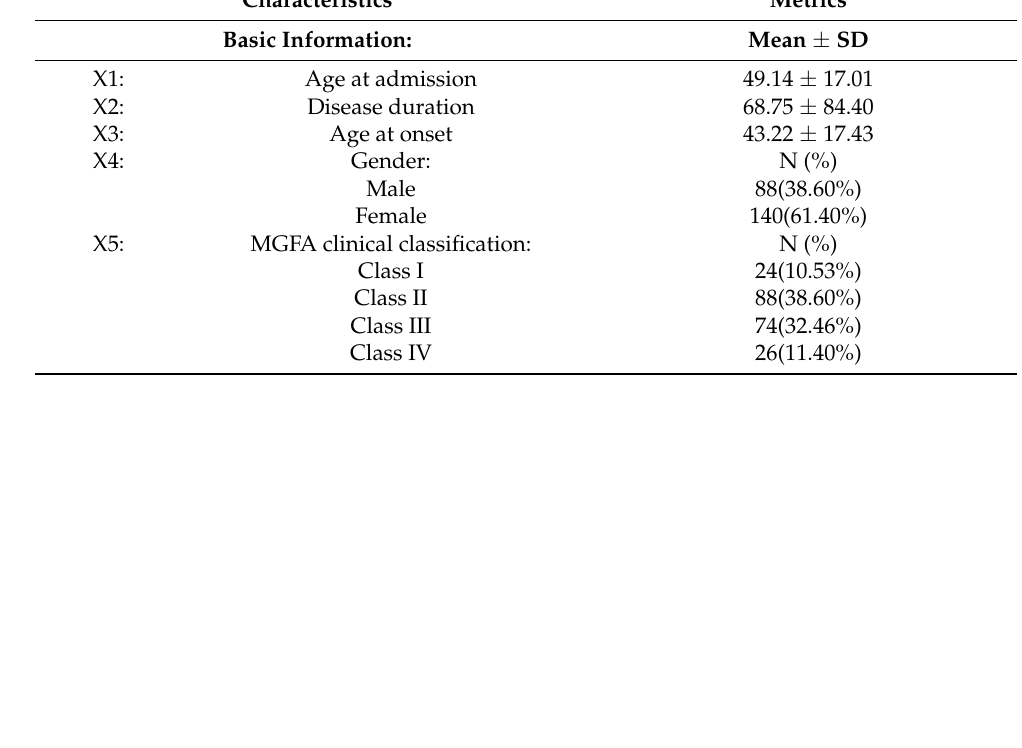
Table 2. Subject demographics.